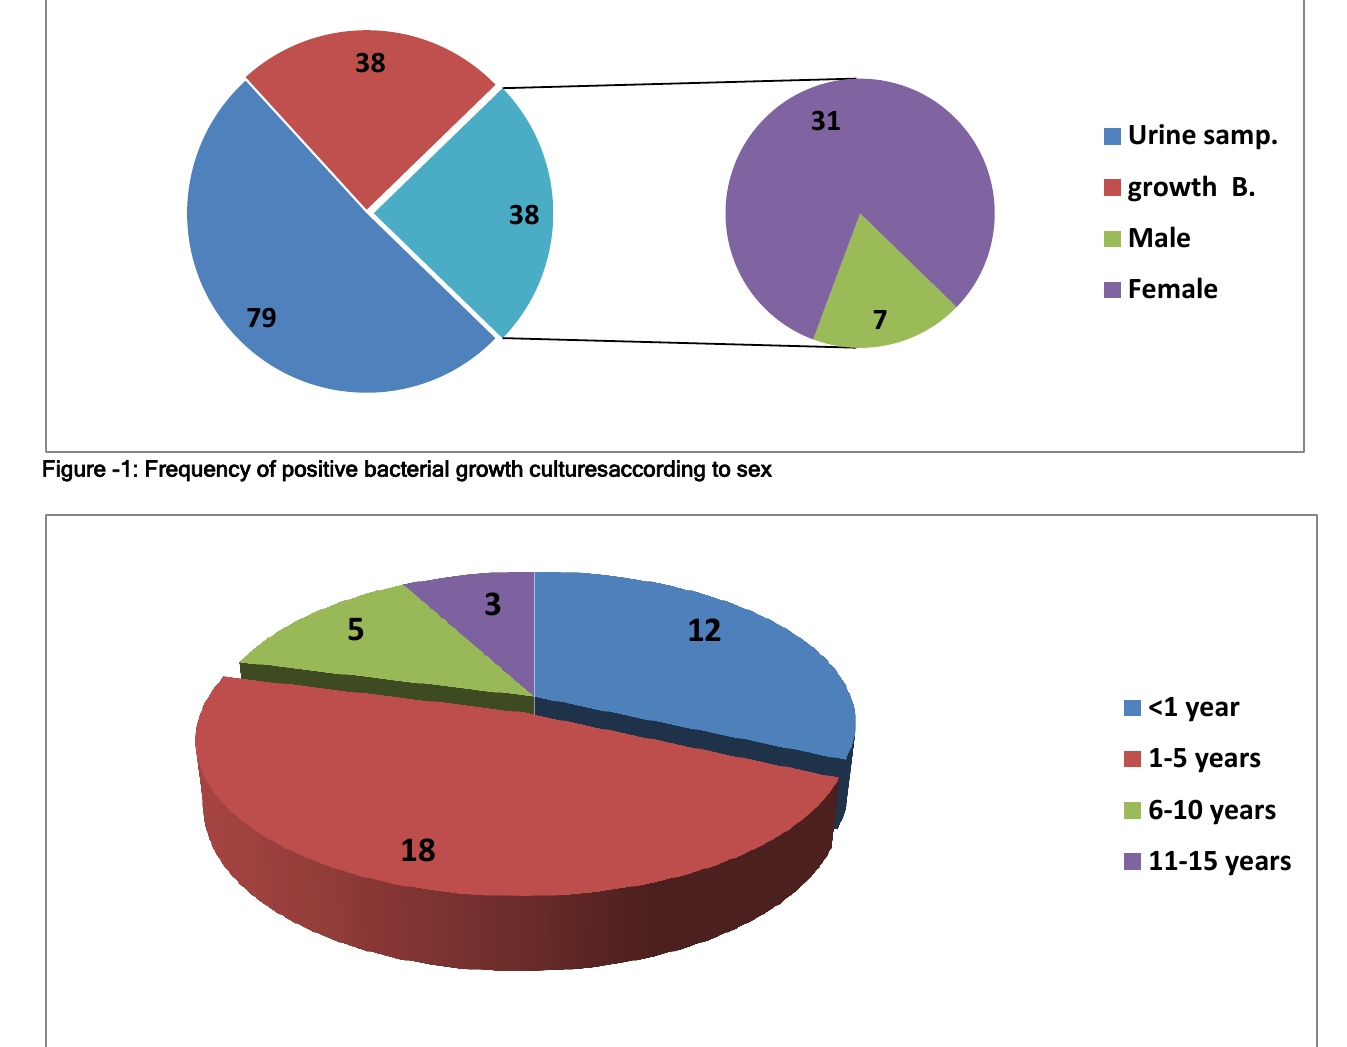
Figure -2: Frequency of positive bacterial growth culturesaccording to